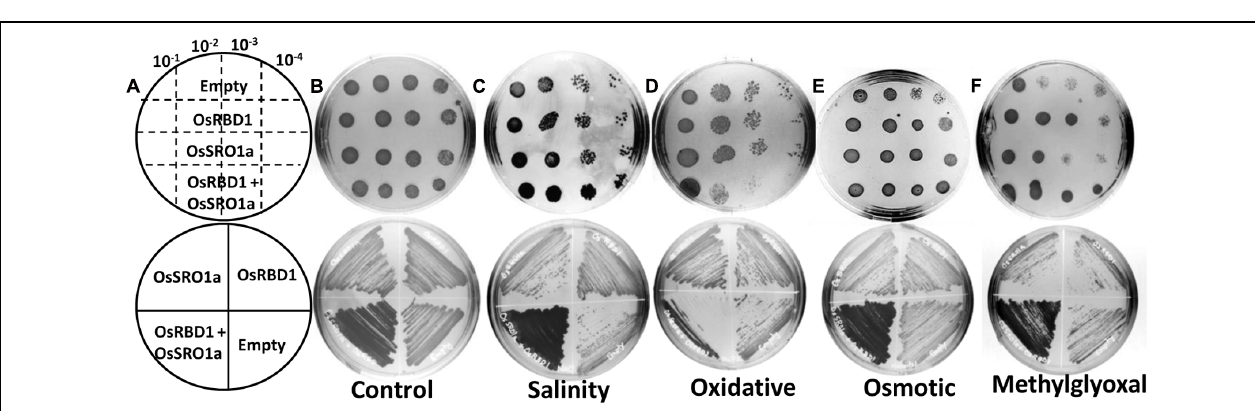
FIGURE 6 | Interaction between OsSRO1a and OsRBD1 provides stress tolerance to Saccharomyces cerevisiae . (A) Schematic depiction of various constructs used for spotting serial dilutions (top panel) and streaking (bottom panel) assays. Comparison of growth and stress tolerance of individually transformed OsSRO1a and OsRBD1 constructs and co-transformed cells containing both the constructs under (B) non-stress (control) conditions, (C) salinity (1.2 M NaCl), (D) oxidative (10 mM H 2 O 2 ), (E) osmotic (1 M mannitol), and (F) methylglyoxal (8 mM) treatments. Empty vector was also transformed and used as control. Top panel in each case represents spotting of serially diluted cultures of the constructs used in the study and bottom panel shows growth after streaking the same constructs. Three clones of each construct were used and the experiment was repeated